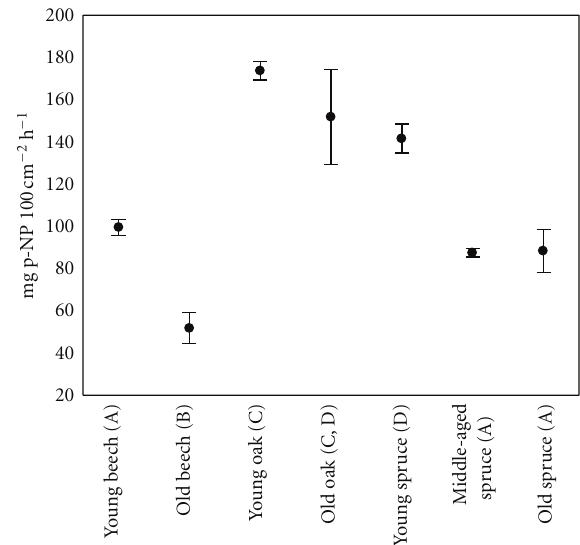
Figure 1: Total soil activity of EAPM, including roots (up to 15cm depth), from seven forest stands (Mean ± SE). Di ff erent letters (in brackets) mark significant di ff erences ( P < 0 . 05).